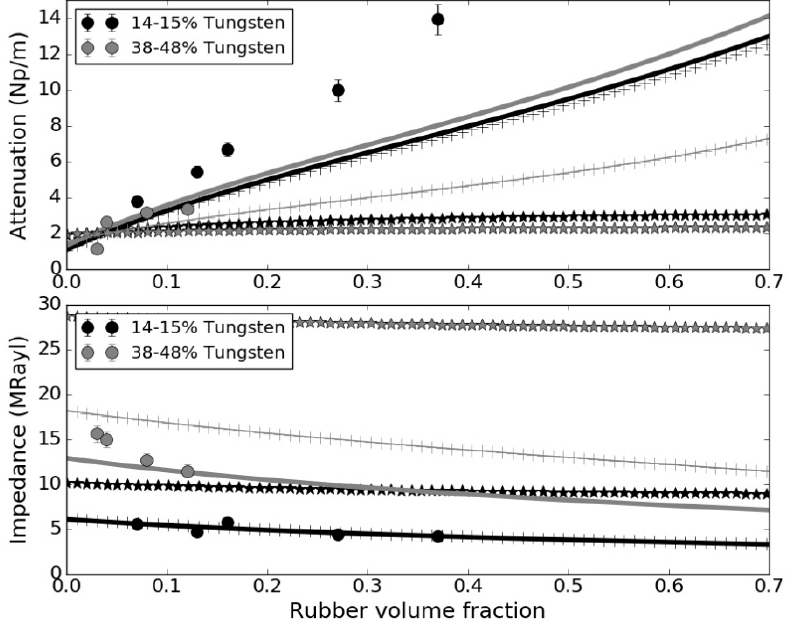
Figure 8. Attenuation ( up ) and Impedance ( bottom ) vs. rubber volume fraction. Gray: tungsten volume fraction: 38–48%. Black: tungsten volume fraction 14–15%. Circles: Experimental measurements; Solid line: HS model, lower bound; Starts: HS model, upper bound; +: CPA model. Finally, Figure 9 shows the variation in the ultrasonic attenuation at 3 MHz with rubber volume fraction for tungsten + rubber + epoxy composite (for both the low and the high impedance series).